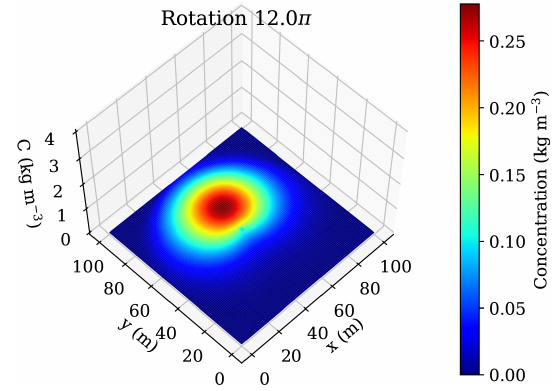
Figure 7. Initial cone shape and location at the beginning of the rotating cone test with a diameter of 30m and maximum tracer con- centration of 3.87kgm − 3 at x = 50m and y = 75m. cone shape at the given infinite Péclet number. During the